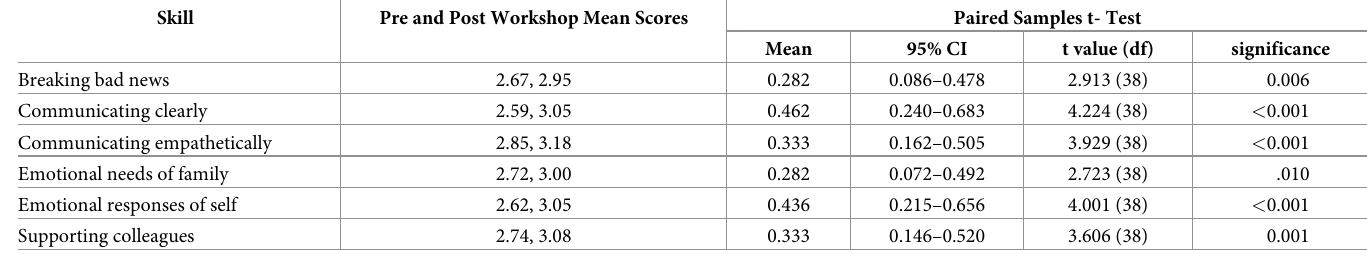
Table 5. Pre and post workshop improvement in confidence in key skills in stillbirth